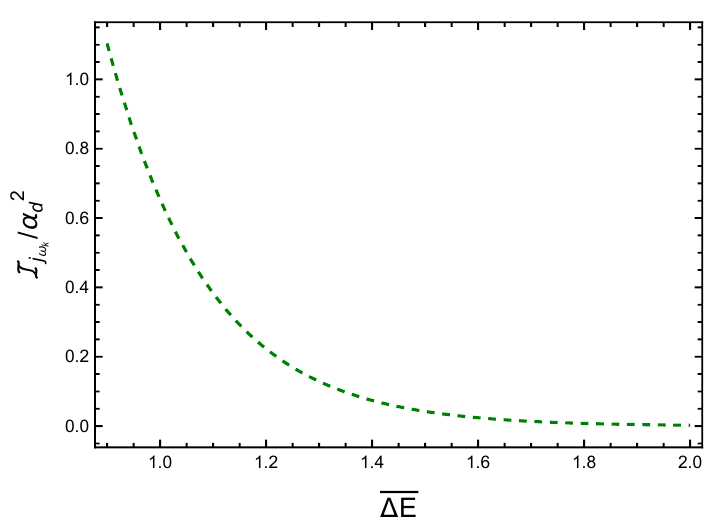
Figure 22 . The quantity C I detectors in a (1 + 3) dimensional de Sitter spacetime with respect to the dimensionless transition energy ∆ E of the detectors for fixed dimensionless frequency of the field ω d/α d = 0 .